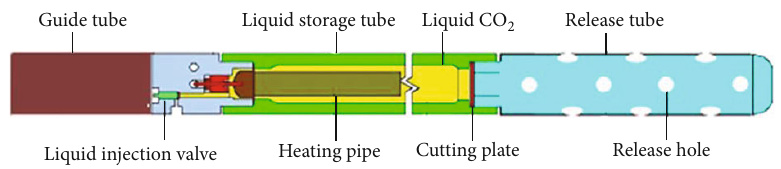
Figure 12: Schematic diagram of liquid CO